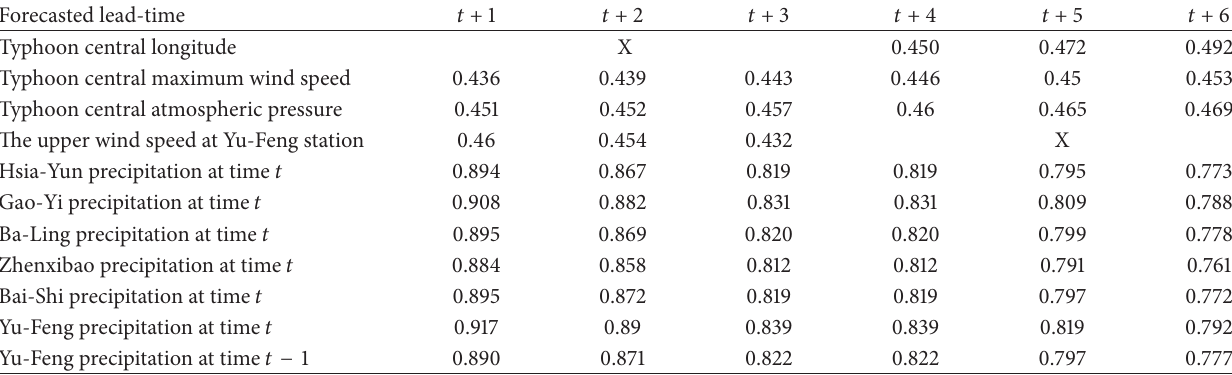
Figure 7: Study area and the distribution of rainfall gauges. Table 2: The selected model inputs and corresponding correlation coefficients for Yu-Feng